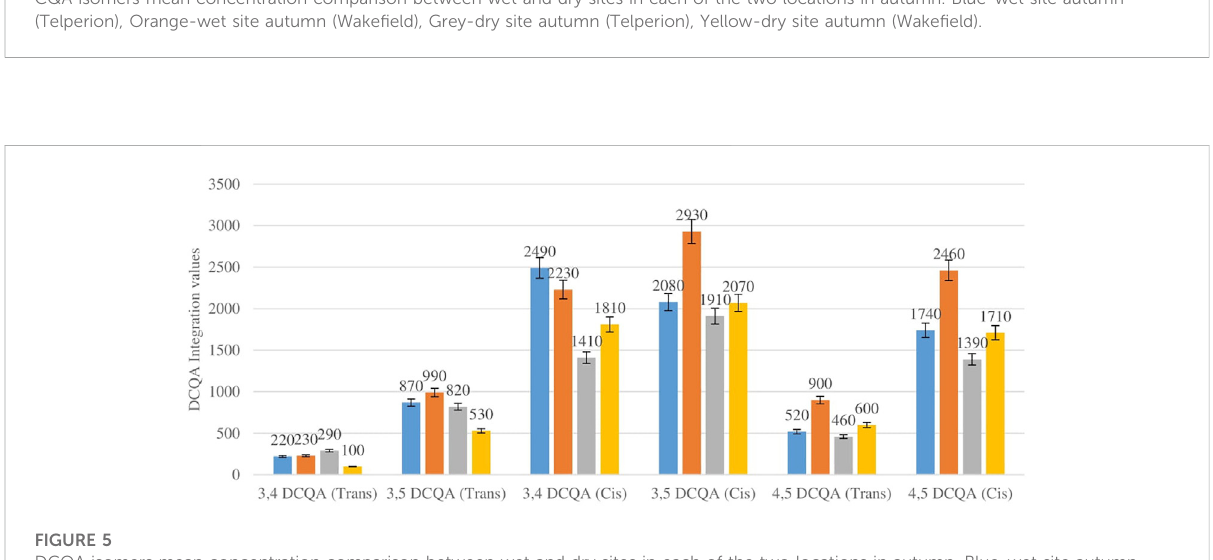
FIGURE 5 DCQA isomers mean concentration comparison between wet and dry sites in each of the two locations in autumn. Blue-wet site autumn (Telperion), Orange-Wet site autumn (Wake fi eld), Grey-dry site autumn (Telperion), Yellow-dry site autumn (Wake fi eld).